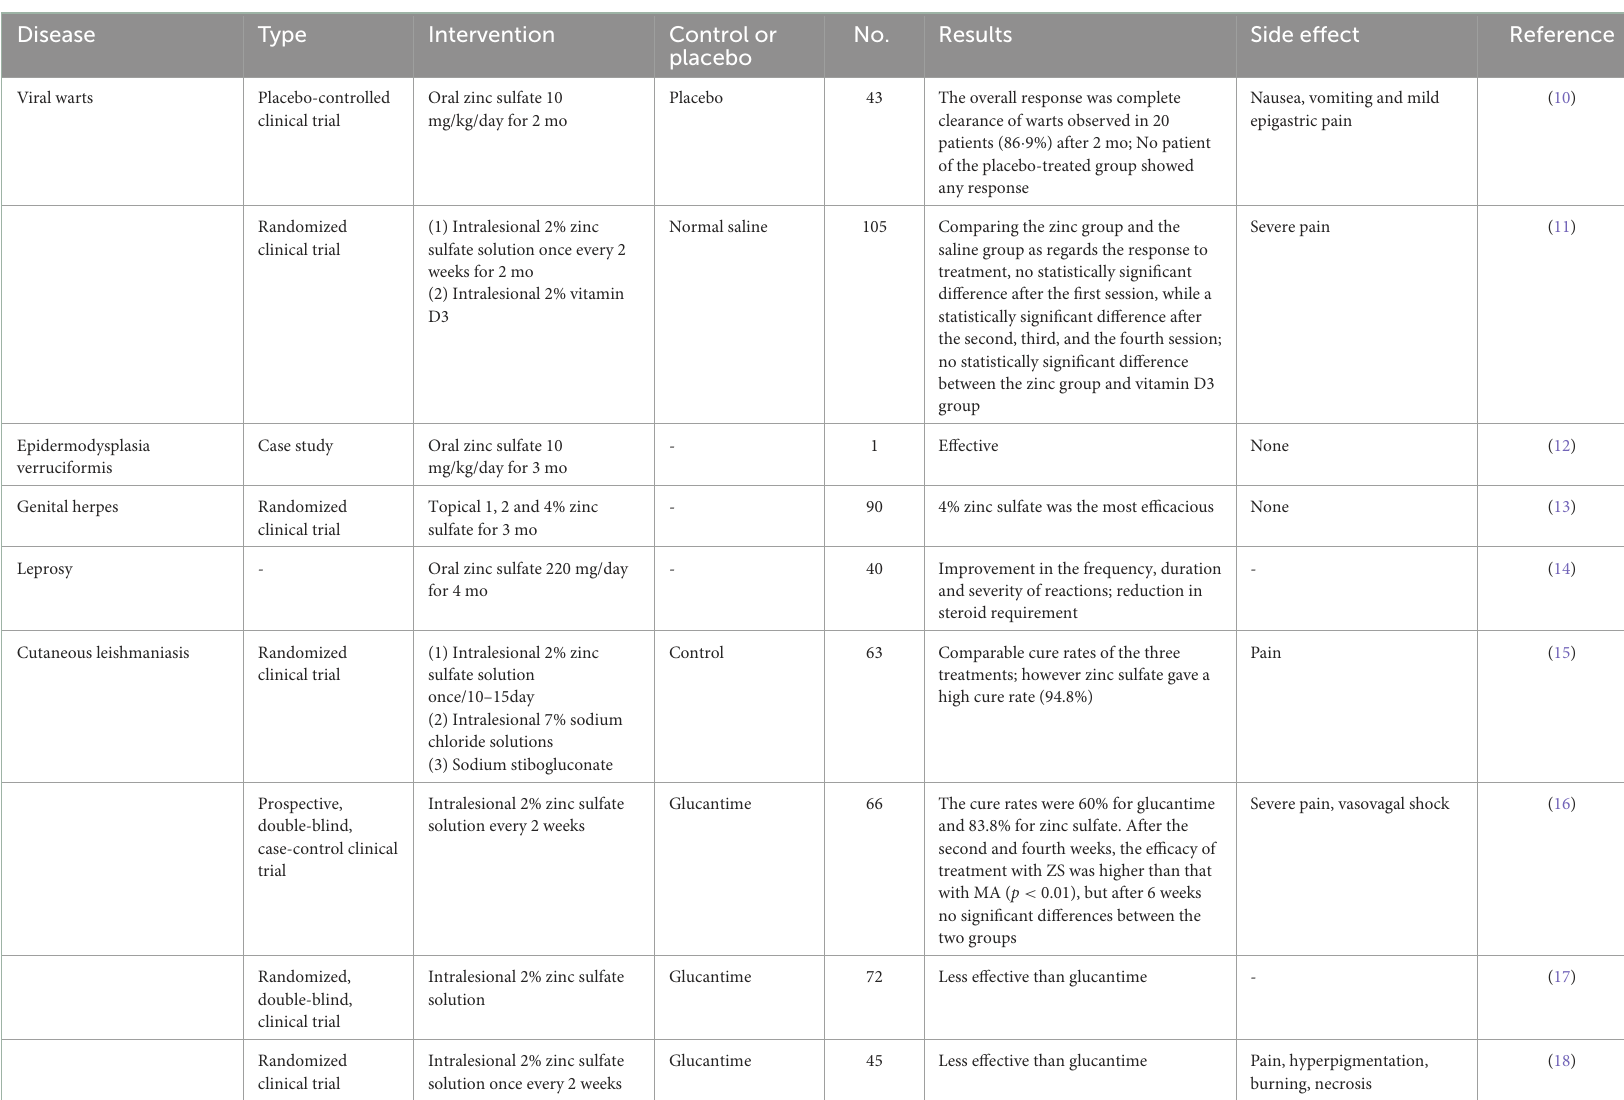
TABLE 1 Human studies of zinc supplementation for the treatment of skin